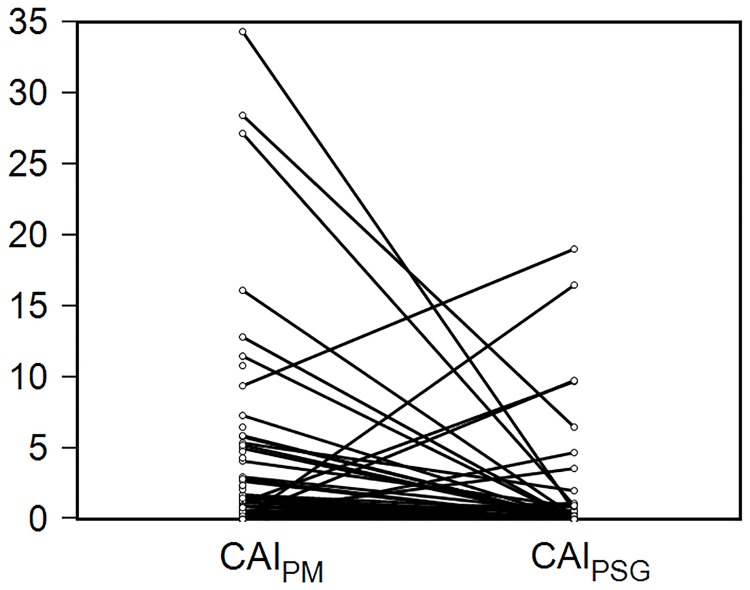
The central apnea indices on portable monitoring and polysomnography.The central apnea index with the portable monitor (CAIPM) during the hospitalization was generally higher than on outpatient polysomnography (CAIPSG).